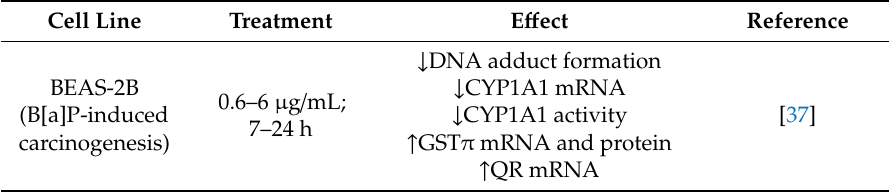
Table 1. E ff ects of carnosol on lung cancer in